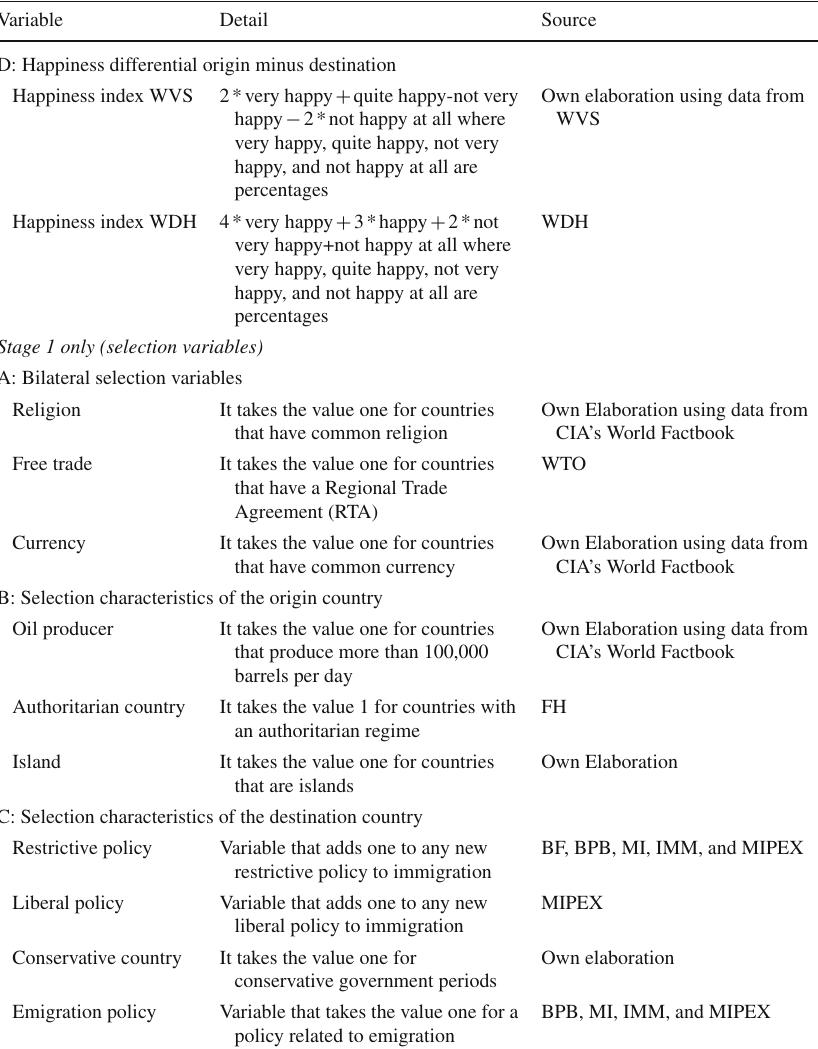
Table 5 Detail of variables